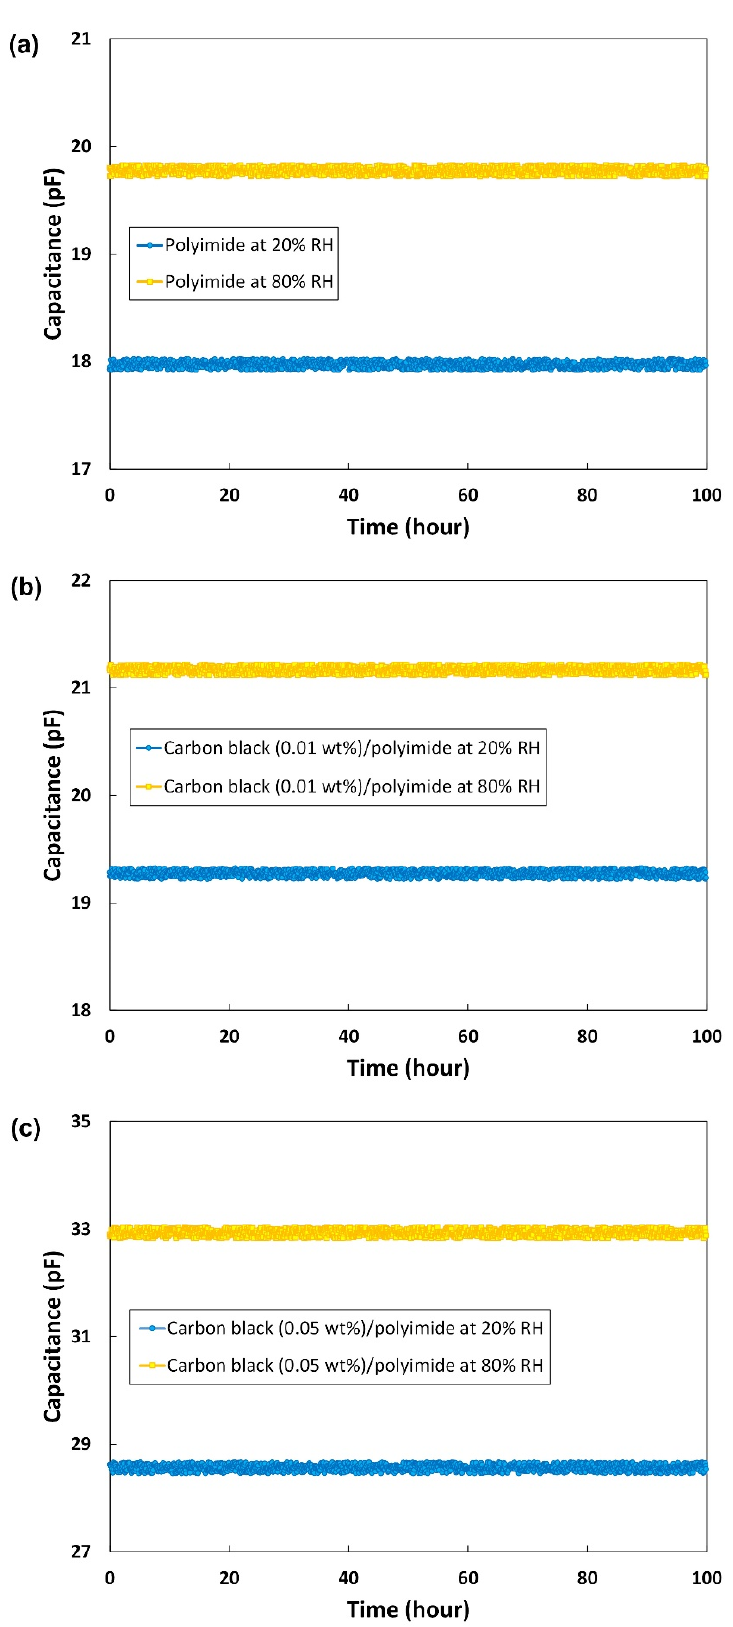
Figure 7. Long-term stability of the humidity sensors with ( a ) pure polyimide, ( b ) carbon black (0.01 wt%)/polyimide, and ( c ) carbon black (0.05 wt%)/polyimide.